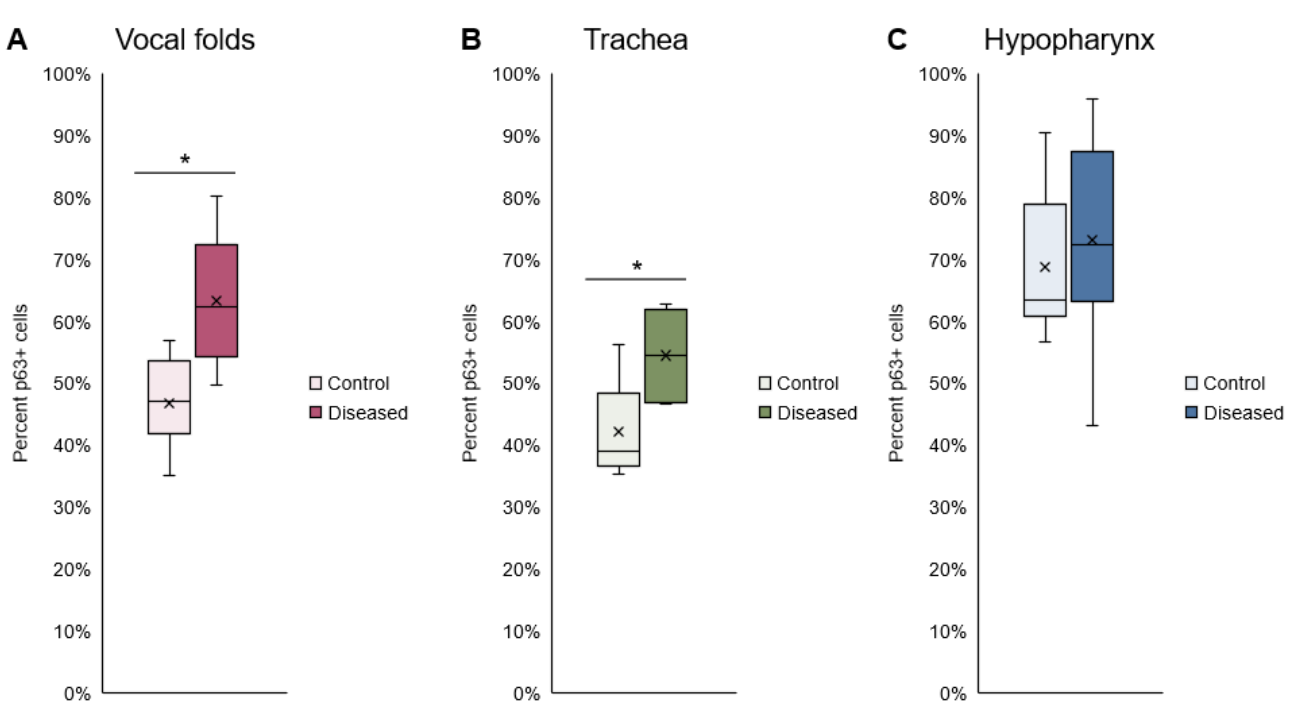
Figure 5. Basal cells increased in diseased vocal folds and trachea after MmuPV1 infection. Percent p63-positive cells in control vs. diseased tissues. *Significant paired T-test. x labels group means. ( A ) Vocal folds: p = 0.0003, n = 10–12 mice per group. ( B ) Trachea: p = 0.0161, n = 6 mice per group. ( C ) Hypopharynx: p = 0.5592, n = 8 mice per group.